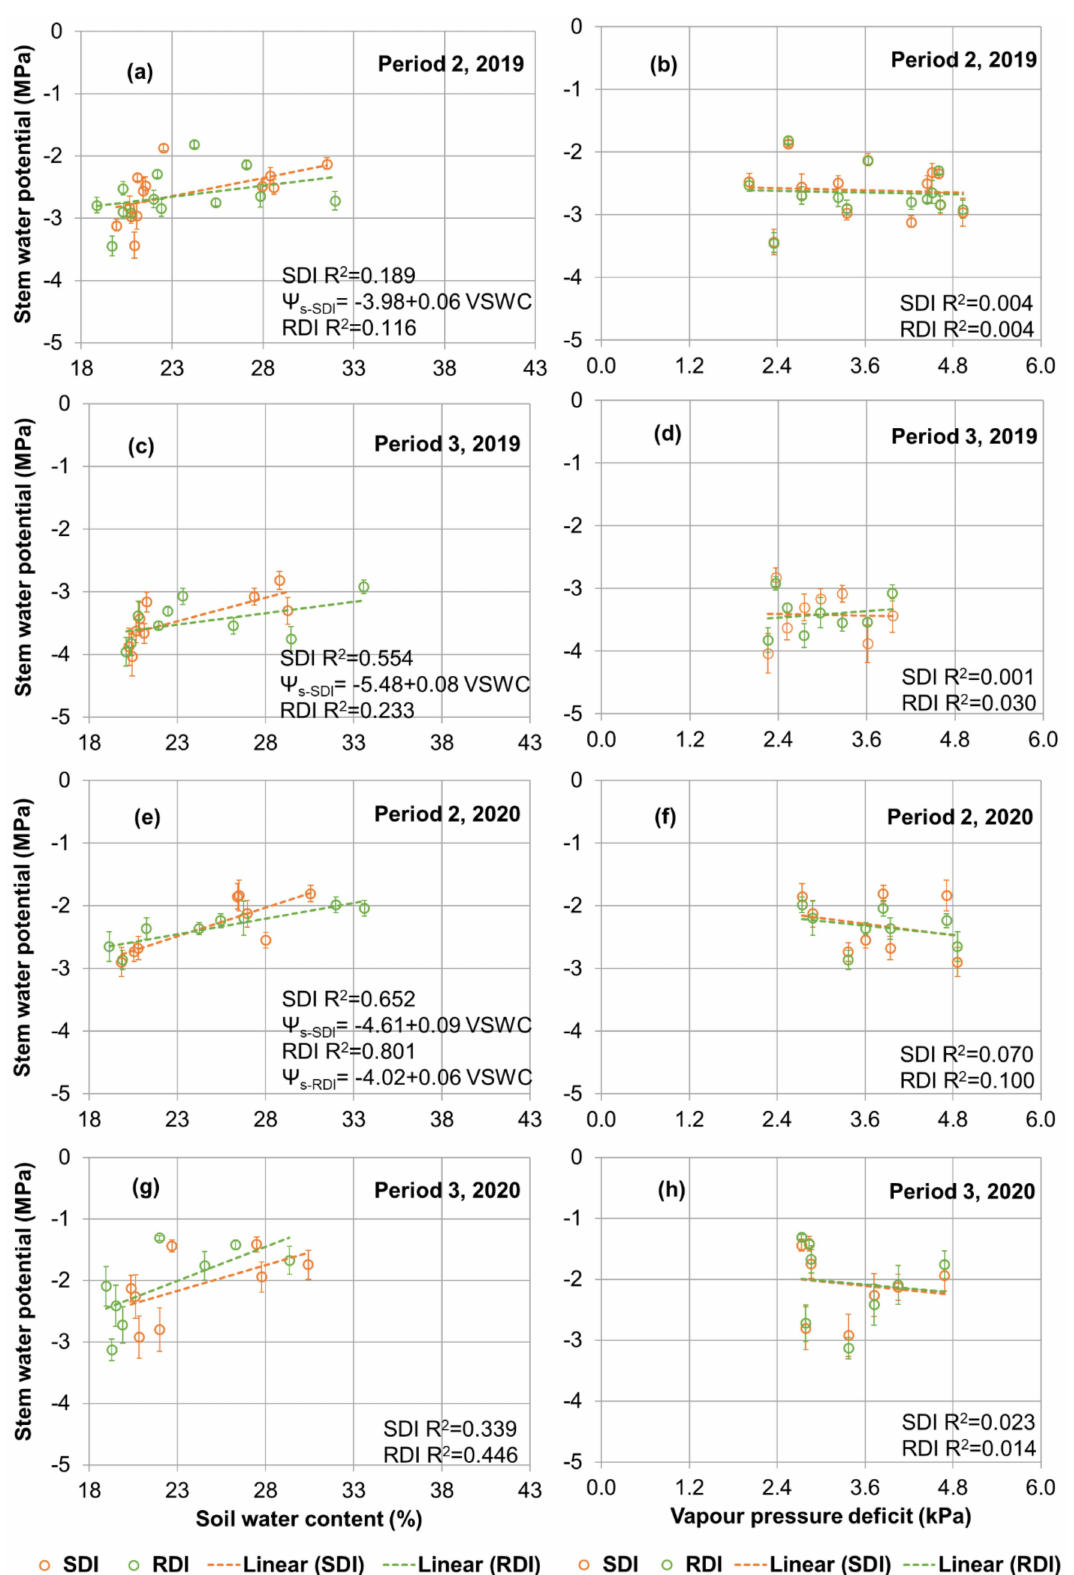
Figure 4. Average stem water potential of five replicate plots in sustained (SDI) and regulated (RDI) deficit irrigation treatments in relation to soil water content (six trees per treatment) and vapour pressure deficit for Periods 2 ( a , b ) and 3 ( c , d ) in 2019 and Periods 2 ( e , f ) and 3 ( g , h ) in 2020. Regression equations are given for statistically significant relations ( p < 0.05). Error bars indicate standard